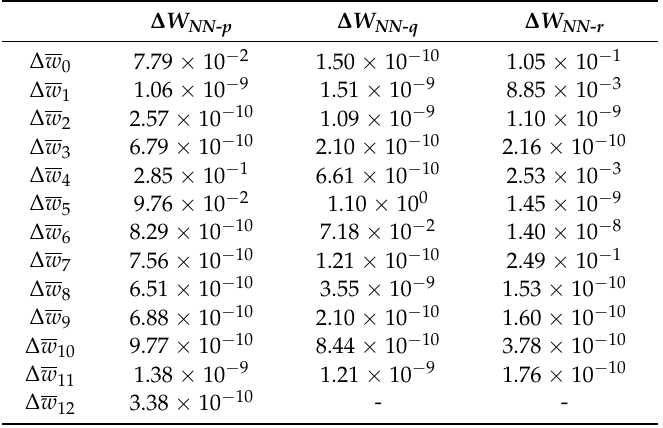
Table 3. Amplitudes of the IM parameters for the three IMU sensors.